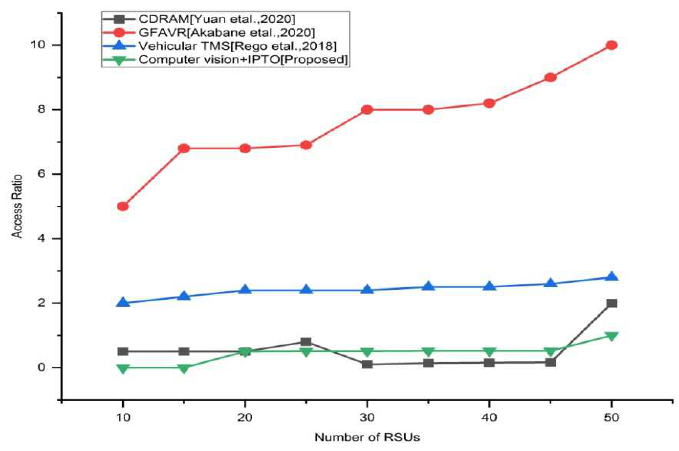
Figure 9. Access ratio vs. different number of RSUs for the existing and proposed method [8,25,26].